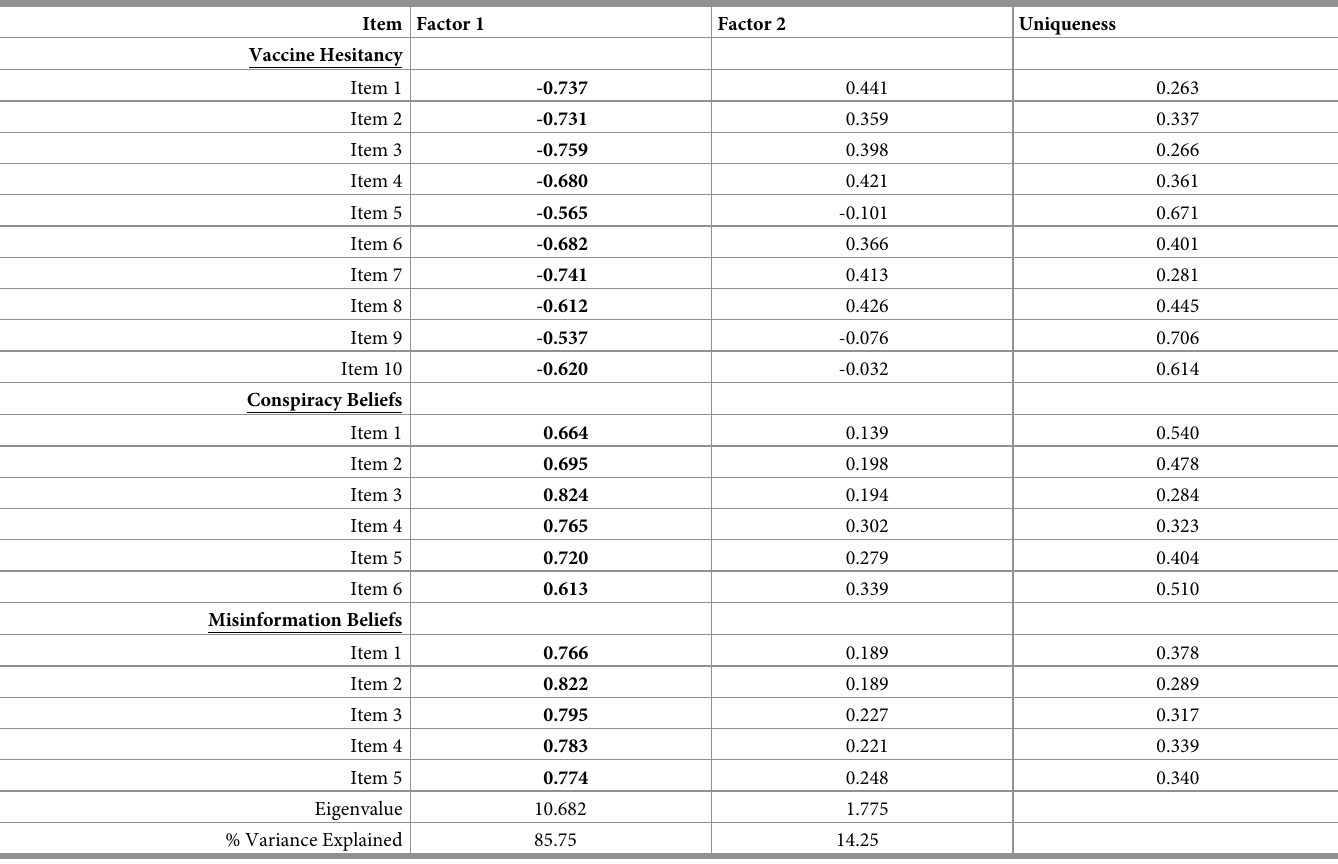
Table 2. Exploratory factor analysis